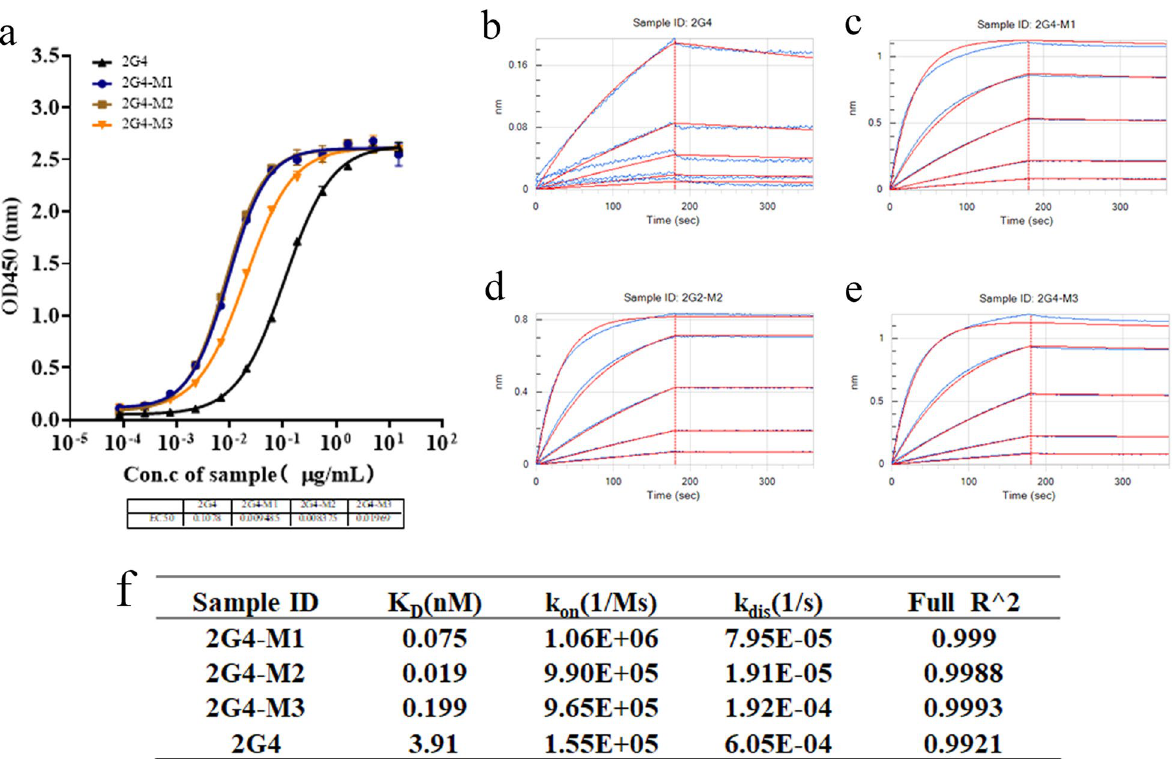
Figure 5. Characterization and comparison of anti-SARS-CoV-2 nucleocapsid protein mutant antibodies. ( a ) The antibody binding activity to the SARS-CoV-2 N protein was detected by an ELISA. ( b – f ) The binding kinetics of antibodies to the SARS-CoV-2 N protein were detected by BLI. Experiments were independently repeated at least three times, and one representative experiment is shown.